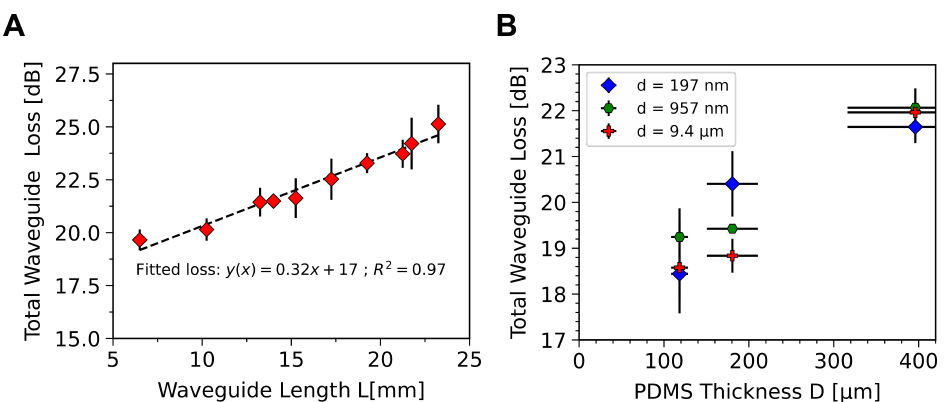
Figure 3. ( A ) Total loss, A t , for 400 µ m thick waveguide with varying length. ( B ) Total loss, A t , versus the waveguide channel thickness (D) for different photoresist thicknesses (d). In both ( A ) and ( B ) the error bars show 1 standard deviation of the data from 50 measurements across 5 devices at each ( A ) waveguide length and ( B ) value of D and d.